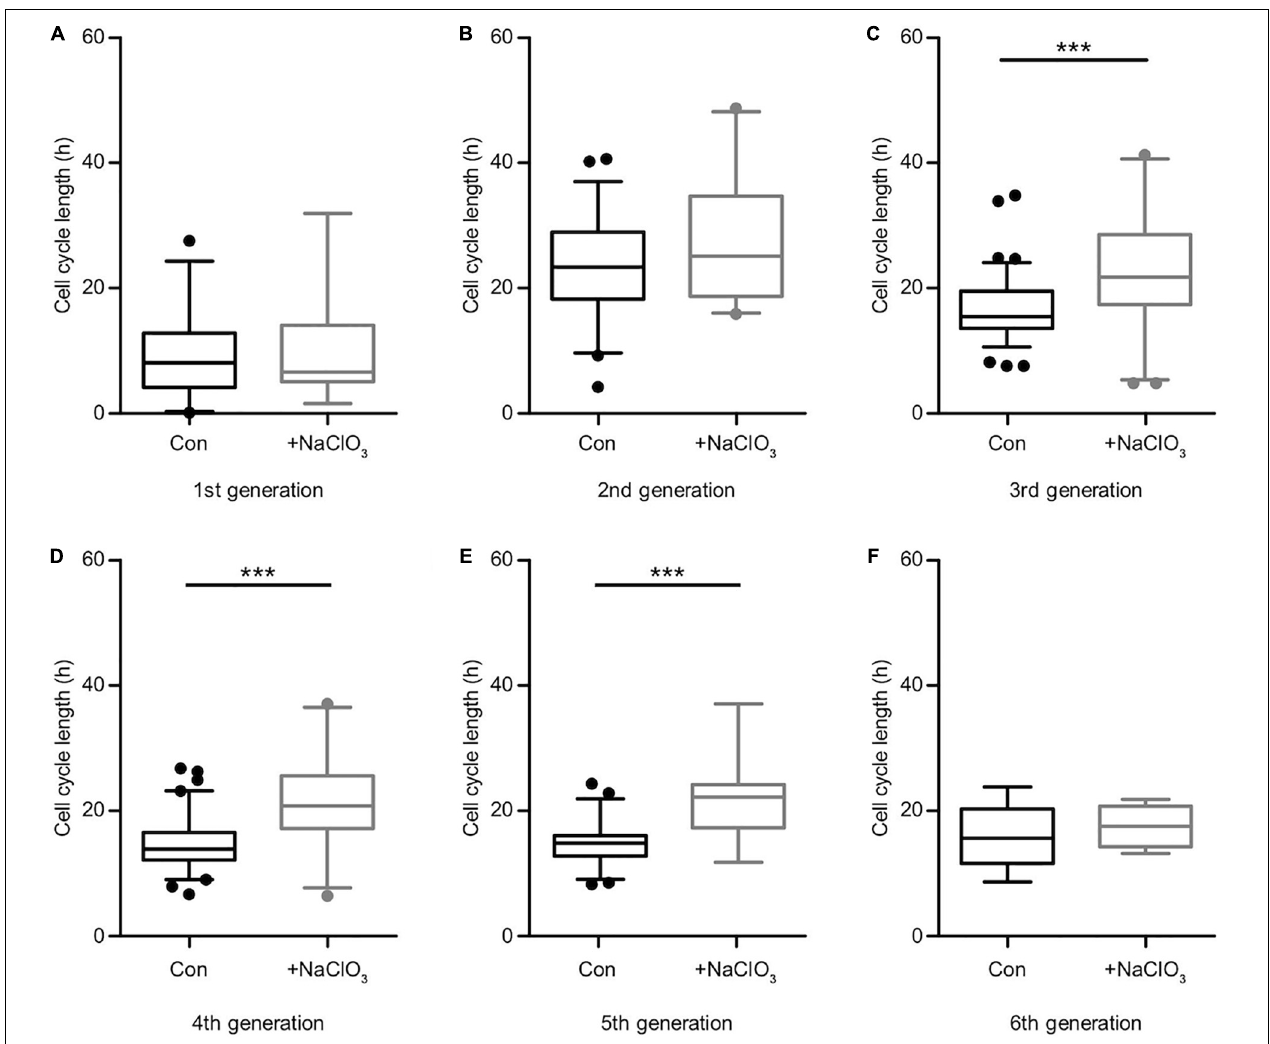
FIGURE 5 | Suppression of sulfation lengthened the cell cycle in the presence of FGF2. Cell cycle lengths of control (black boxes) versus chlorate-treated (gray boxes) spinal cord progenitors maintained in the presence of FGF2 were compared. The cells from the first generation (A) were captured at different starting points of their division cycle and could only be tracked for an undefined portion of the running cell cycle. From the second generation (B) on the cell cycle lengths could be compared statistically. The inhibition of sulfation led to a slower cell division of progenitors treated with chlorate. The prolongation of the cell cycle was particularly striking between the 3rd up to the 5th round of division (C–E) . The sixth generation (F) was only traceable for a few cells (compare to the lineage tree in Figure 4E ) *** p ≤ 0.001 (Mann–Whitney U -test); con: N = 4; chlorate: N =